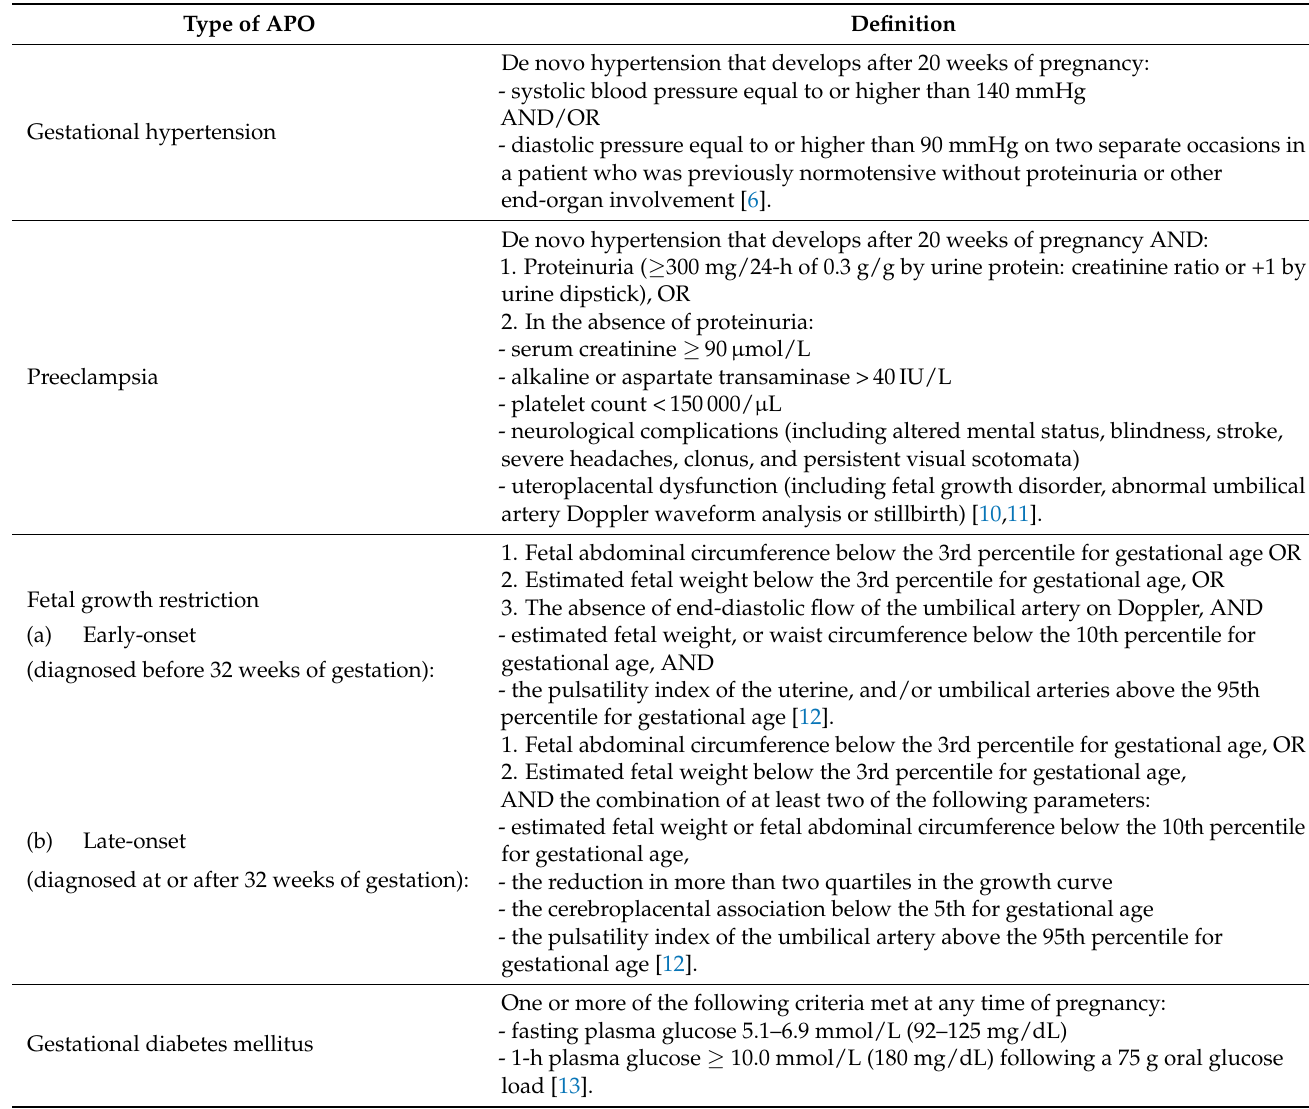
Table 1. Definitions of adverse pregnancy outcomes